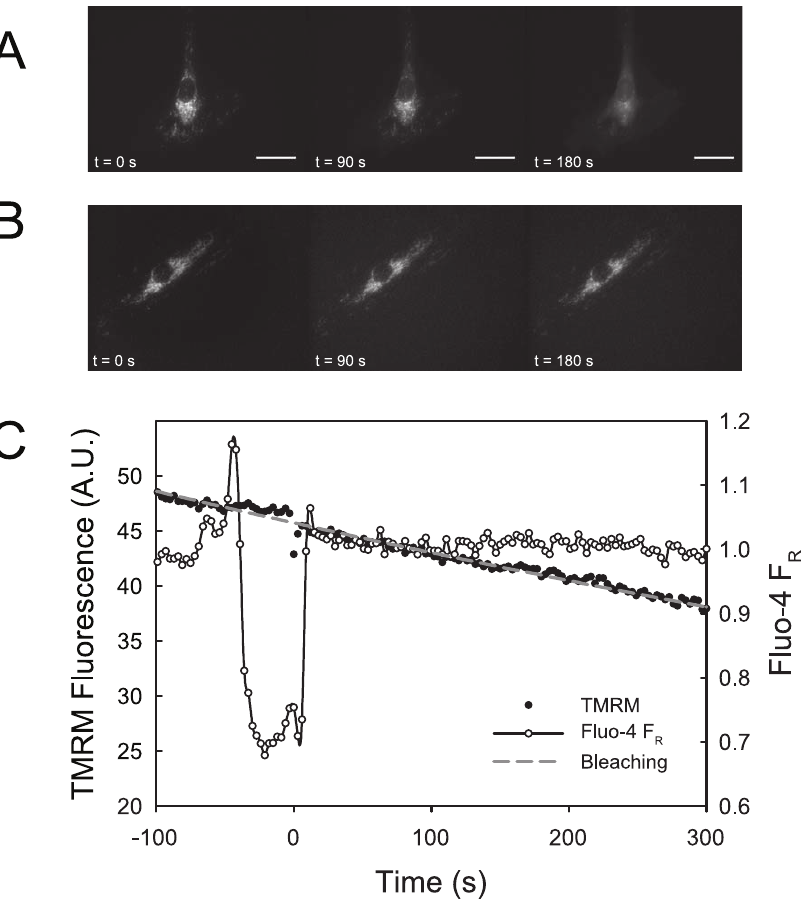
Figure 4. Pre-treatment with 5% BSA prevents air bubble-induced mitochondrial depolarization. A ) Montage of fluorescent photomicrographs of TMRM loaded HUVEC illustrating the progression of DY m loss following air bubble contact under control conditions. The time- stamps indicate time relative to bubble contact and the scale bar indicates 20 m m. The reduced background in the first frame is the result of the presence of the air bubble, which displaces the buffer (which contributes background fluorescence). B ) Montage of fluorescent photomicrographs of TMRM loaded HUVEC treated with 5% BSA prior to air bubble contact illustrating maintained DY m . The time-stamps indicate time relative to bubble contact and the scale bar indicates 20 m m. C ) Corresponding traces of fluorescence signals obtained from HUVEC loaded with DY m indicator TMRM (left axis, solid circles) and intracellular calcium dye Fluo-4 (right axis, open circles) responding to air bubble contact at t=0 following pre-treatment with 5% BSA. Dashed grey line represents the expected exponential decay of the signal, primarily due to